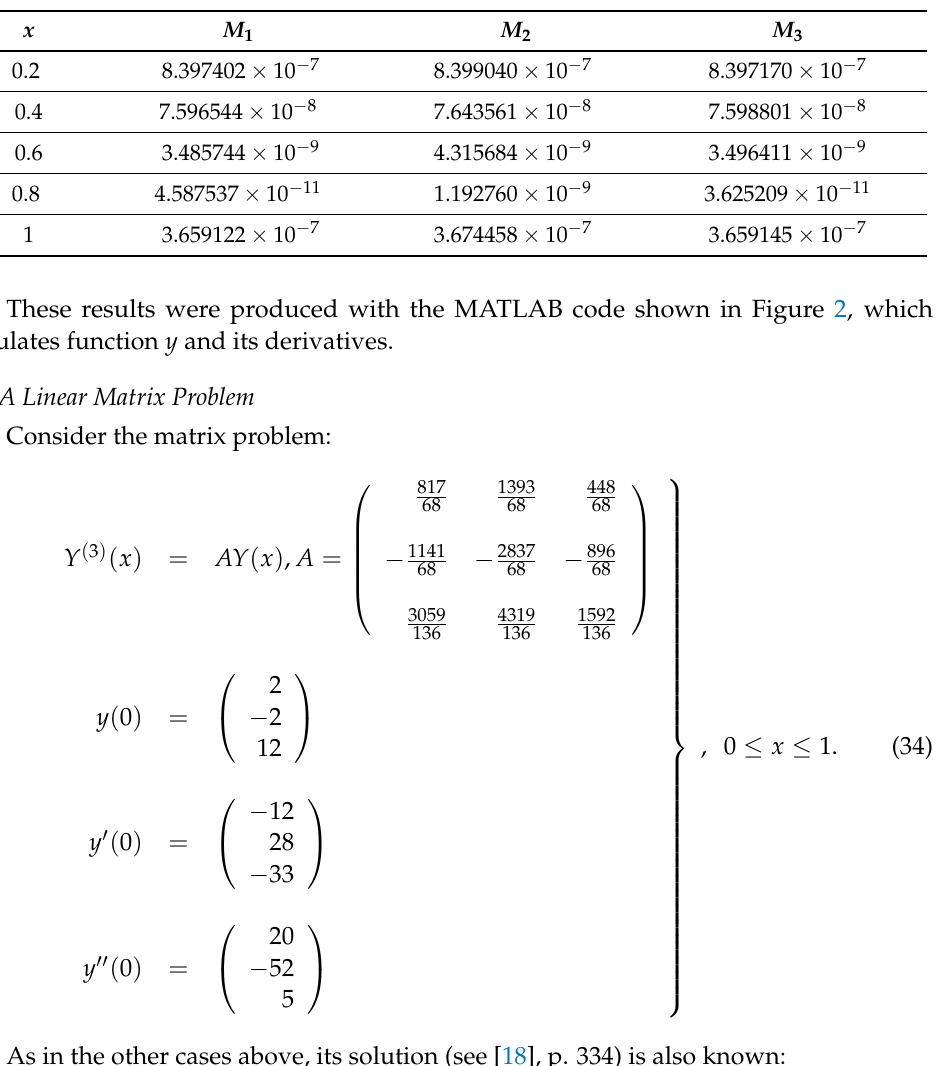
Table 9. Relative errors of the Mechee ( M 1 ), Khataybeh ( M 2 ), and spline-based ( M 3 ) methods in the film flow problem (33).